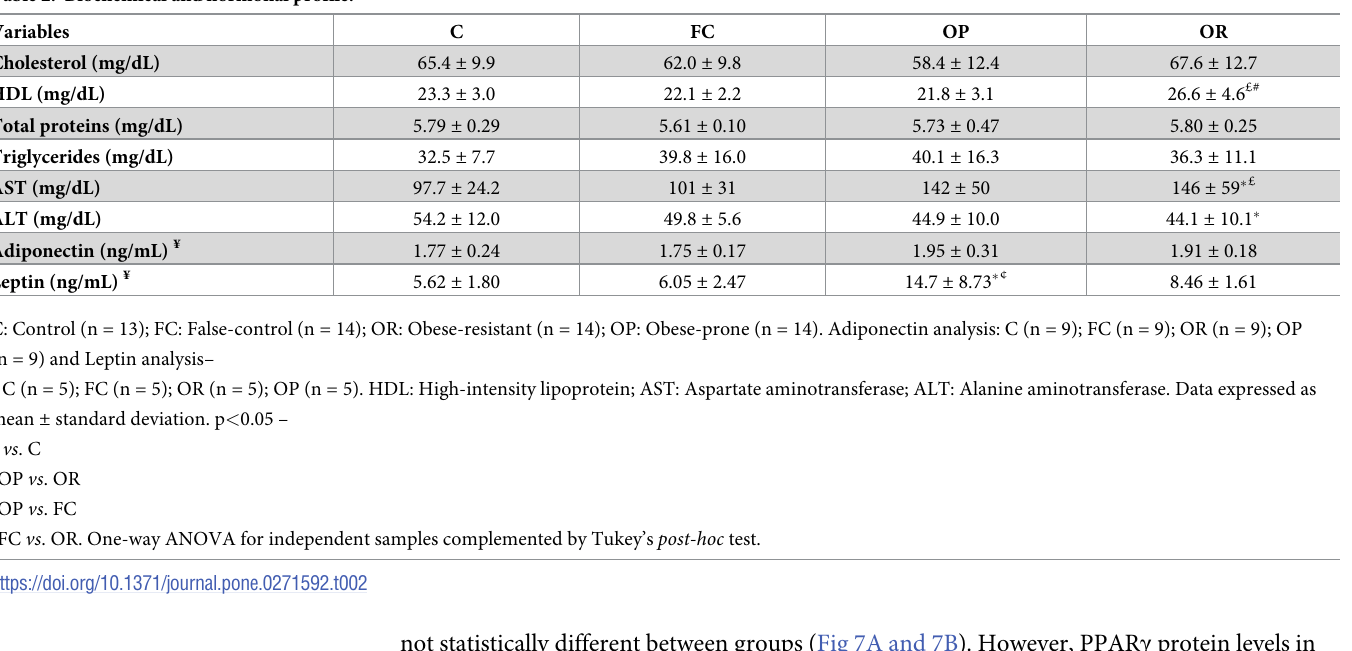
not statistically different between groups (Fig 7A and 7B). However, PPAR γ protein levels in the soleus skeletal muscle were higher in OR compared to groups C (p < 0.0037) and OP (p < 0.0040), with no significant difference in relation to FC group (Fig 7C).